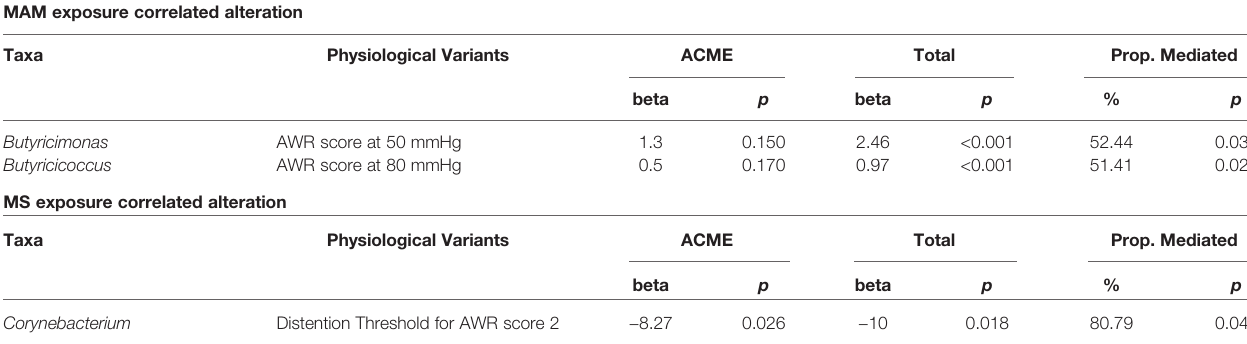
TABLE 1 | Gut microbiota composition mediates the association between early adversity and altered physiological